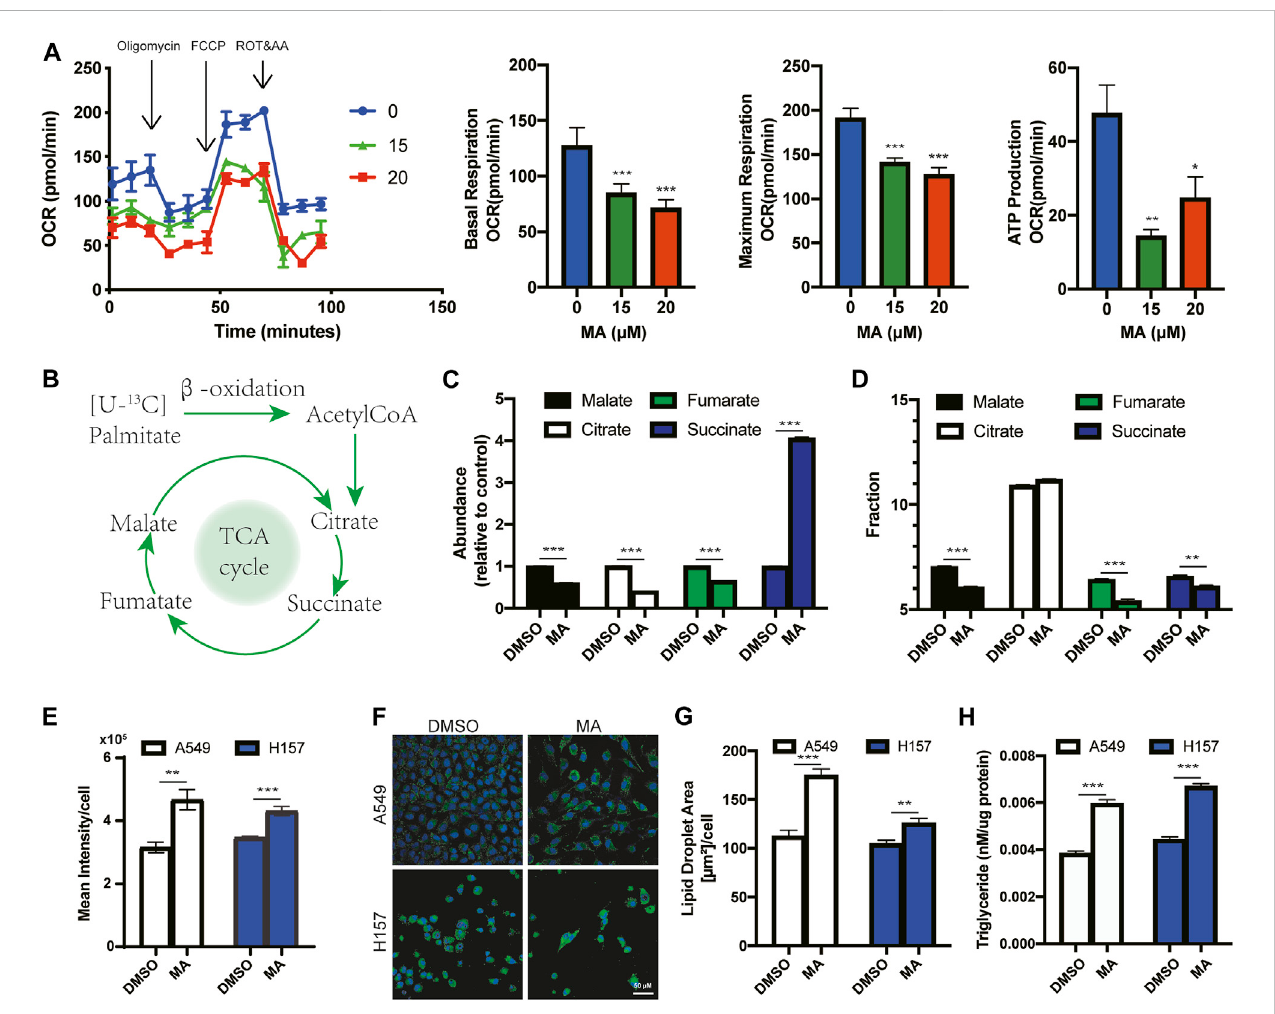
FIGURE 4 MA reduces mitochondrial oxidative metabolism and promotes the accumulation of lipid droplets. (A) Oxygen consumption rate (OCR) in A549 cells treated with MA. (B) Schematic diagram of palmitic acid oxidation into intermediates of the TCA cycle. (C) The abundance of TCA intermediates in A549 cells treated with MA (15 μ M). (D) 13 C fraction of TCA intermediates in A549 cells treated with MA (15 μ M). (E) Lipid droplet quanti fi cation by fl ow cytometry of A549andH157cellstreatedwithMA(15 μ M). (F) Representativeconfocal fl uorescencemicroscopyimagesoflipiddropletstainingwithBODIPY493/503 (green) in A549 cells and H157 cells treated with MA (15 μ M). (G) Quanti fi cation of the lipid droplet area per cell in A549 and H157 cells. (H) Triacylglycerols were measured in A549 and H157 cells treated with MA (15 μ M). * p < .05, ** p < .01, *** p <